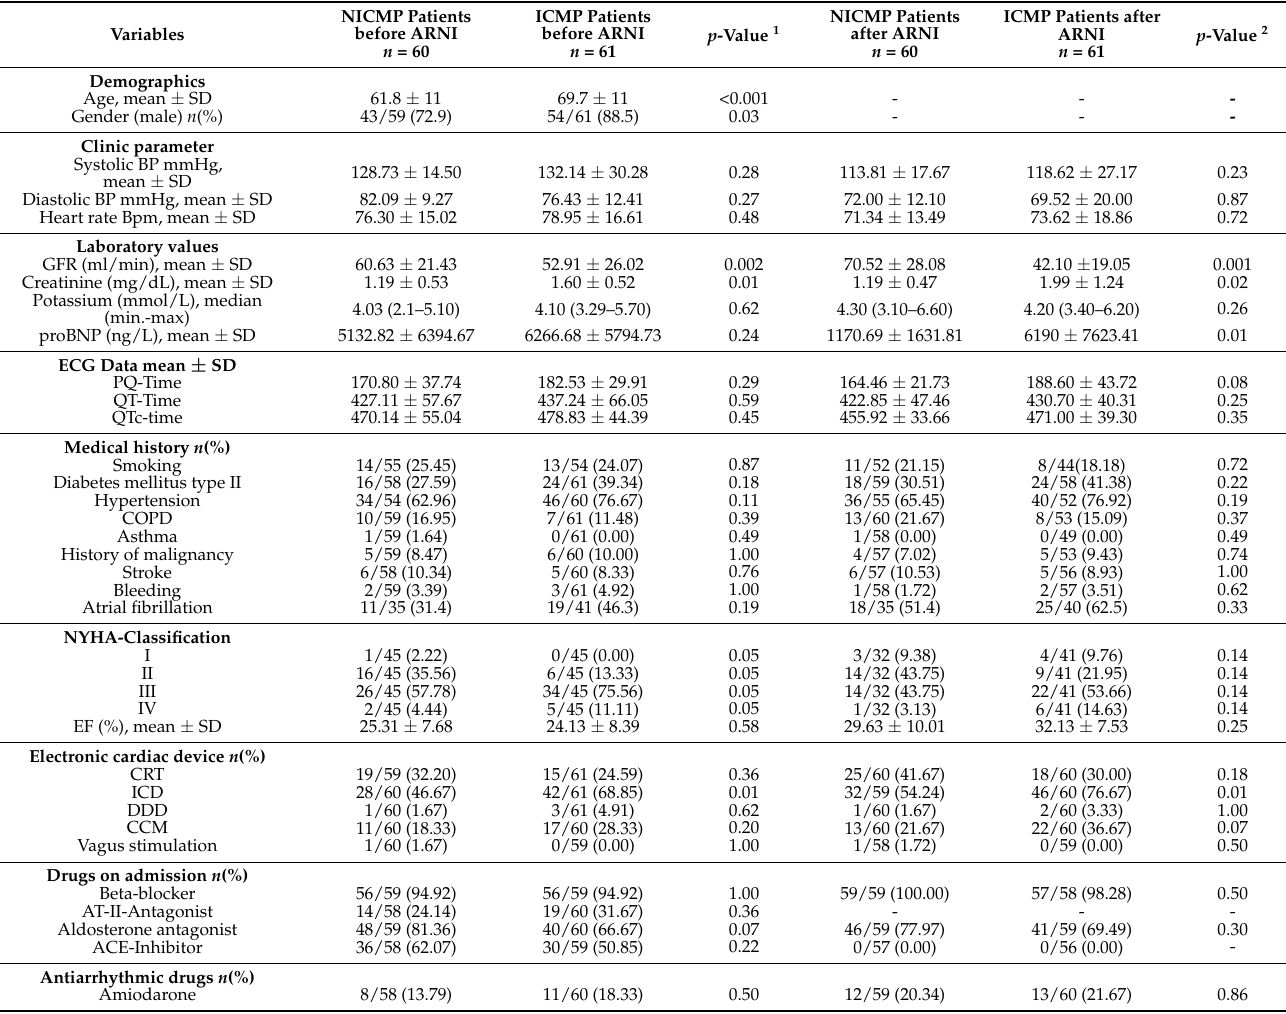
Table 1. Baseline characteristics of NICMP and ICMP patients presenting at the beginning of the treatment with ARNI and one-year